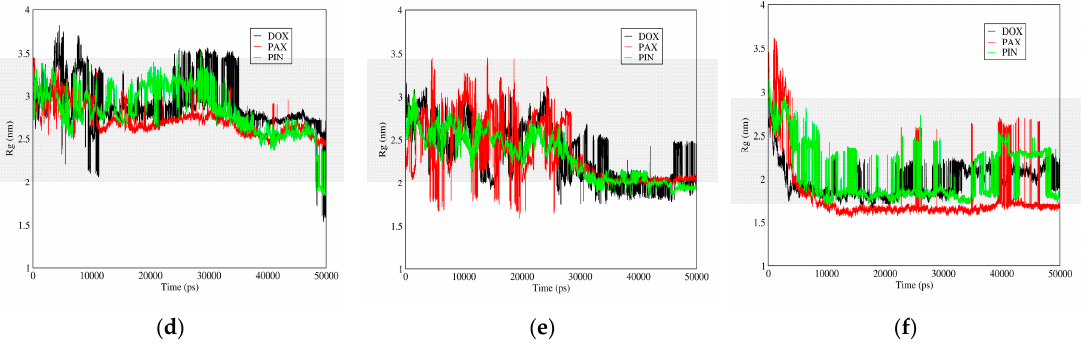
Figure 13. Gyration Radius of DOX, PAX, and PIN versus time in neutral and acidic pH for different carriers: ( a ) CNT in neutral pH; ( b ) Fullerene in neutral pH; ( c ) GO in neutral pH; ( d ) CNT in acidic pH; ( e ) Fullerene in acidic pH; ( f ) GO in acidic pH.